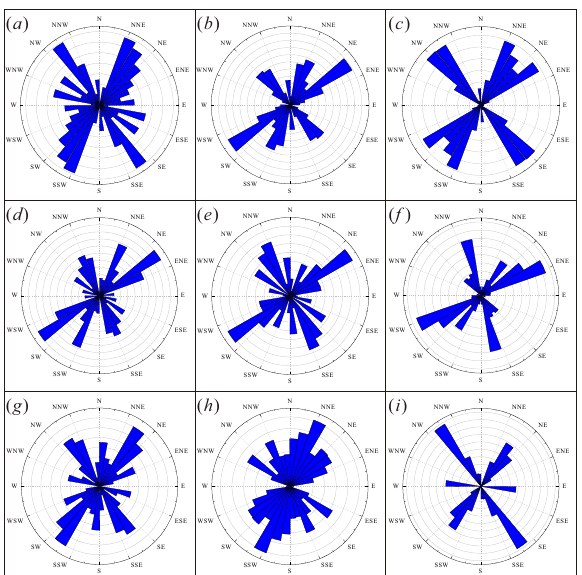
Figure 7. The main orientation of the lineaments for each